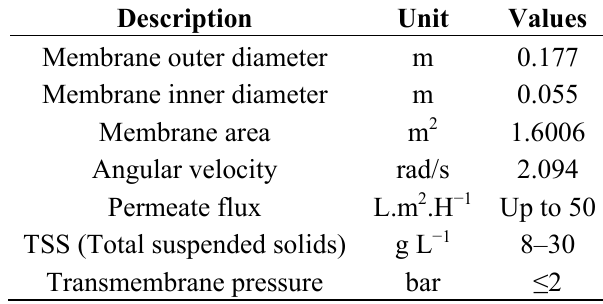
Table 1. Dimensions and operating conditions of the FUV-185-A15R